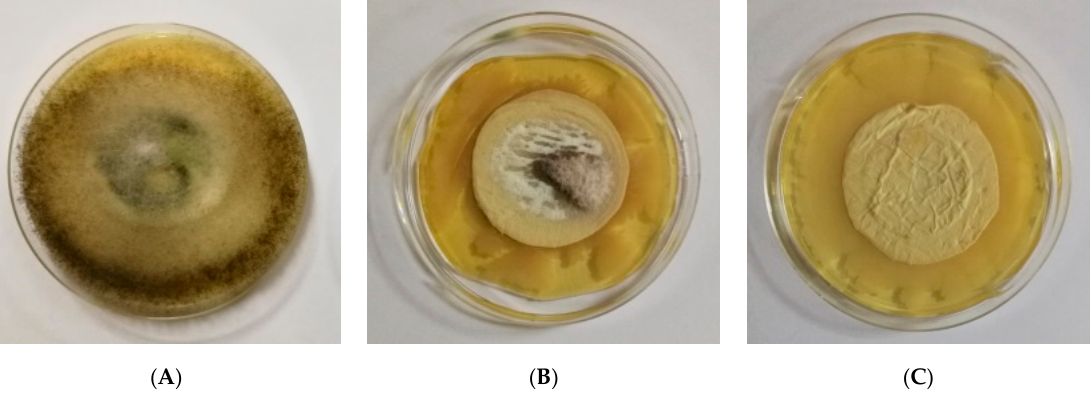
Figure 10. Digital images of the growth P. chlamydospora on the fibrous materials: ( A ) PHB, ( B ) TiO 2 - in -PHB and ( C ) TiO 2 - on -PHB.